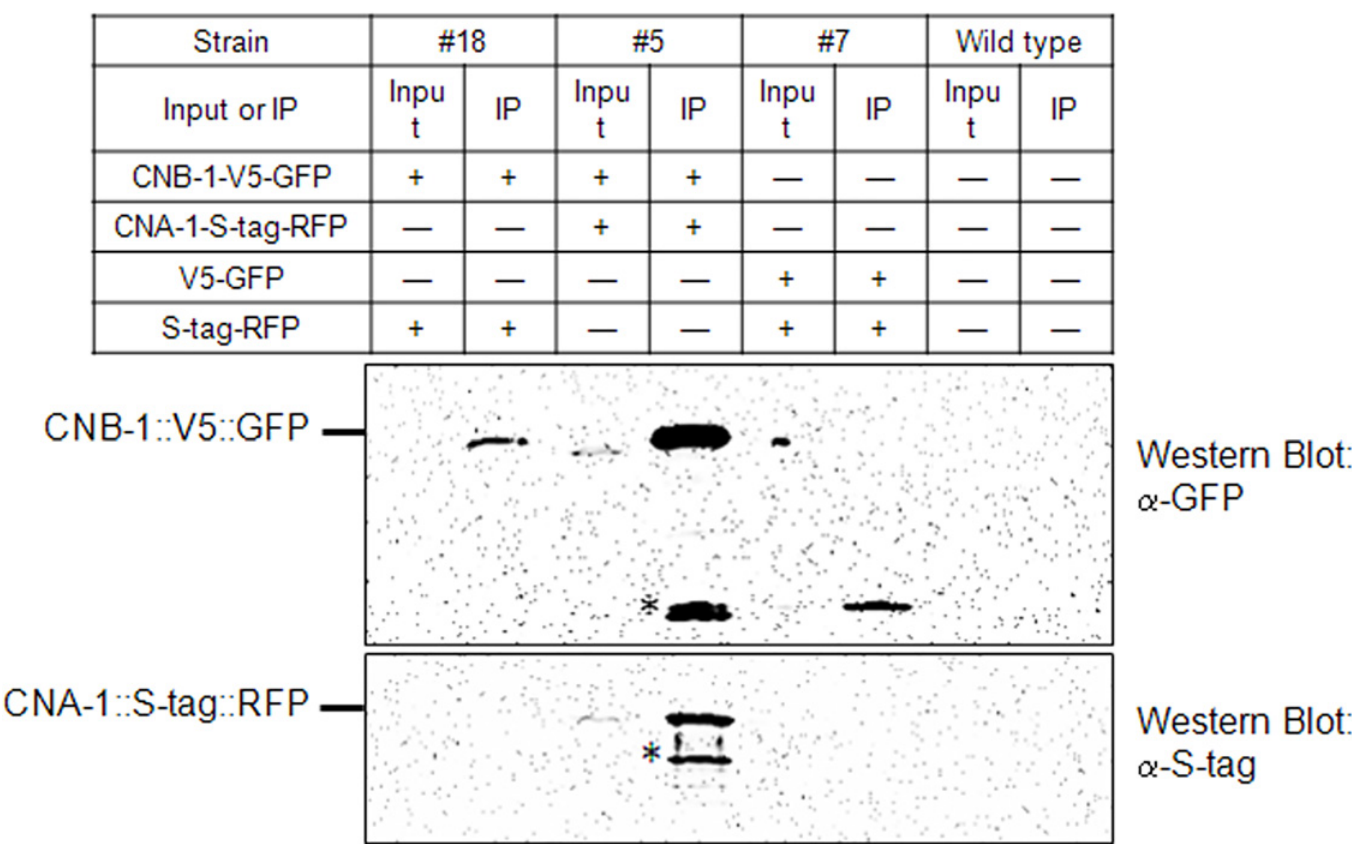
Fig 4. Co-immunoprecipitation of CNA-1 and CNB-1 proteins. The indicated heterokaryons (#5, 7, and 18), and the wild type strain were grown for 16 h in submerged culture as described in the Materials and Methods. The soluble fraction was isolated and immunoprecipitated using anti-GFP antibody coupled to agarose beads. Samples of whole cell lysates (Input) and immunoprecipitated proteins (IP) were subjected to Western blot analysis using GFP (top), and S- tag (bottom) antibodies as described in Materials and Methods. The line indicates position for bands of the CNB-1::V5::GFP (~48 kDa; Top Blot) and CNA-1:: S-tag::RFP (~ 93 kDa; Bottom blot) proteins. The asterisk is pointing to a smaller molecular weight molecule possibly resulted from proteolytic cleavage of CNB-1::V5::GFP and CNA-1::S-tag::RFP.